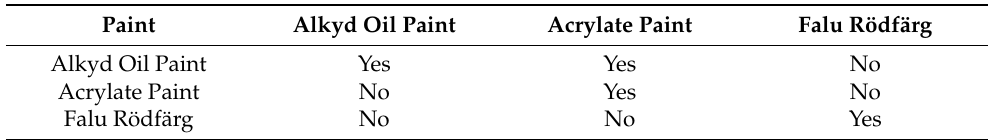
Table 1. Paints compatible with previously conducted paint on new construction in terms of mainte- nance